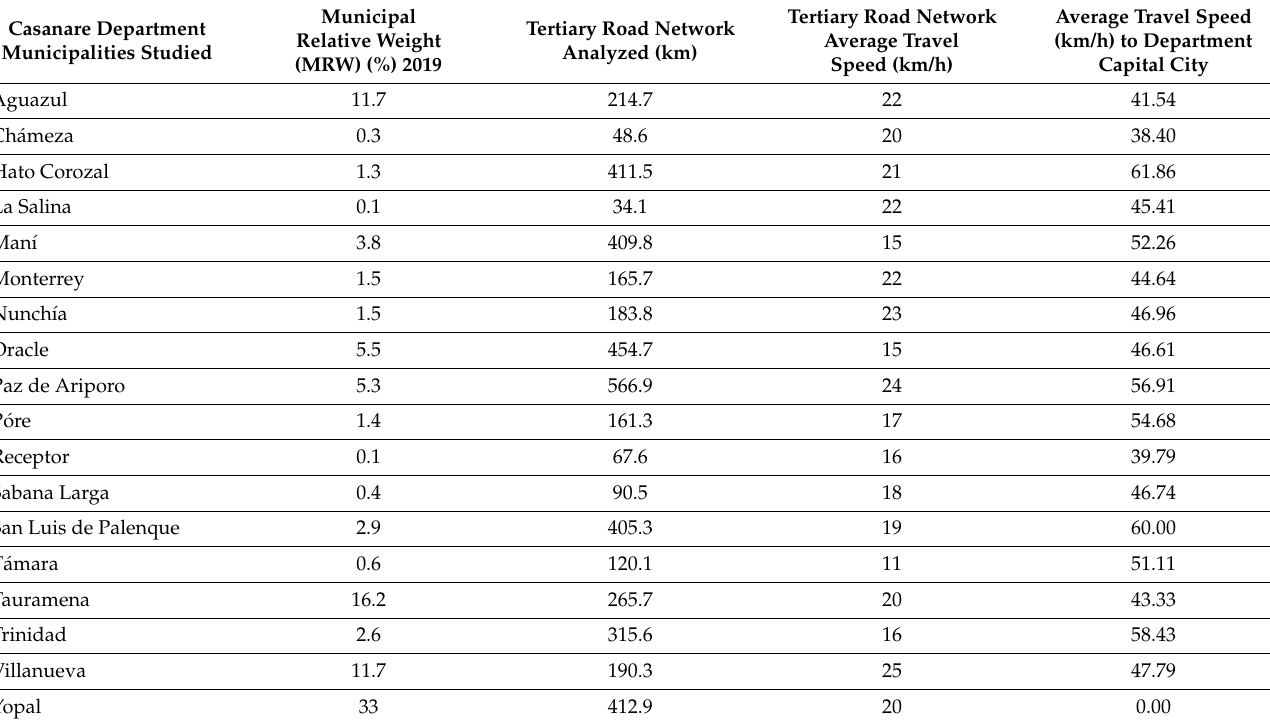
Table A1. Casanare department municipalities studied information: MRW, tertiary road network length, and average travel